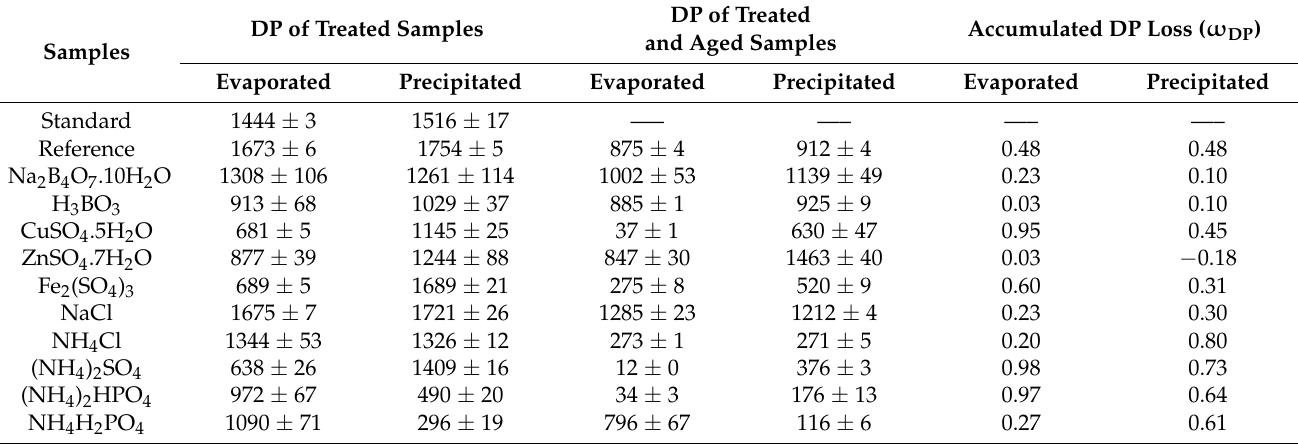
Table 1. The degree of polymerization (DP) data (mean ± SD) and the accumulated DP loss in chemically treated and aged cellulose